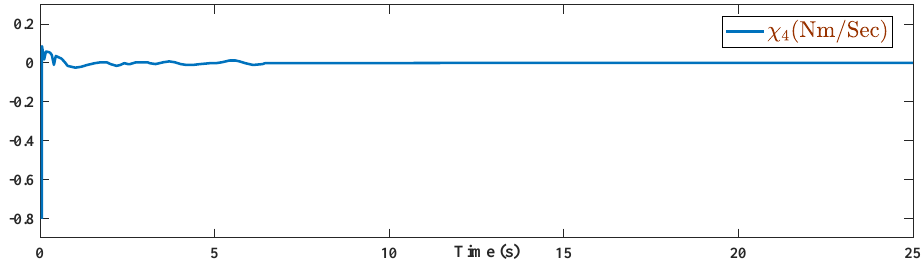
Figure 17. Time response of x 4 related to Scenario 2.